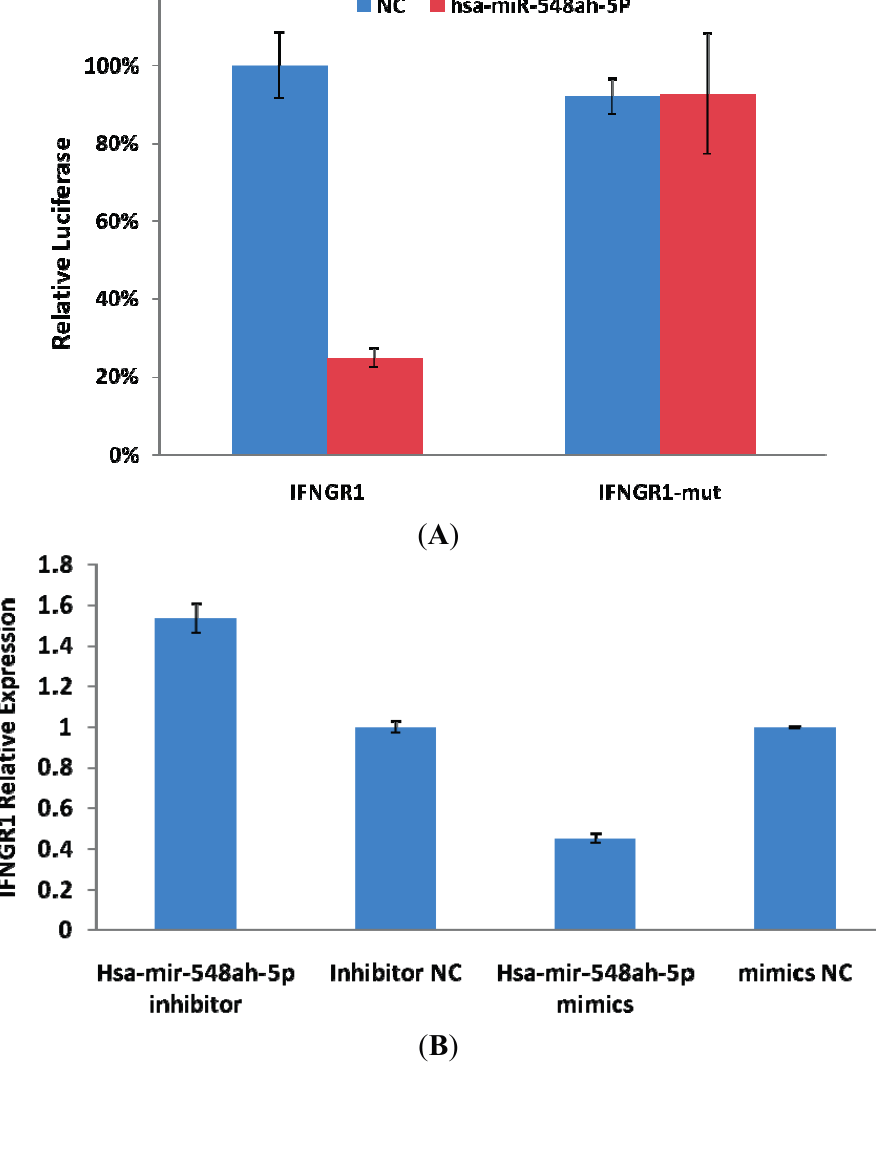
Figure 3. Suppressed luciferase activity of wild type 3'-UTR of IFN- γ R1 by miR-548ah mimic ( A ); The expression of IFN- γ R1 mRNA in THP-1 cells regulated by miR-548ah mimics and inhibitor ( B